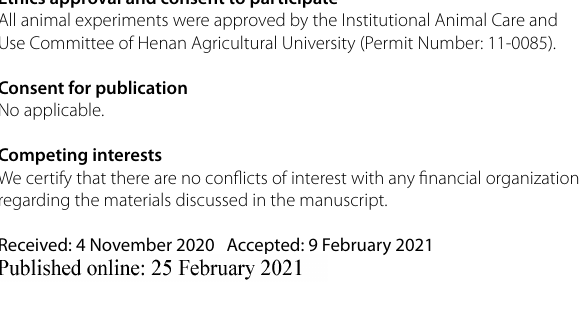
Table S1. Statistics of the paired‑end reads in both groups. Table S2. Genus‑level intestinal microbiota difference analysis results for the different groups. Abbreviations CP: Complete intensive feeding pattern; EP: Extensive feeding pattern; PRRS: Porcine reproductive and respiratory syndrome; IACUC : Institutional Animal Care and Use Committee; BGI: Beijing Genomics Institute; OTUs: Operational taxonomic units; RDP: Ribosomal Database Project; PCA: Principal component analysis; ACE: Abundance‑based coverage estimation; PCoA: Principal coor‑ dinate analysis; LefSe: Linear discriminant analysis effect size; rRNA: